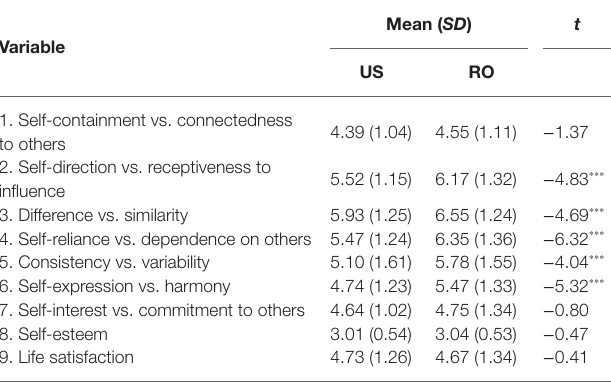
TABLE 7 | Means, SD, and t -tests for differences between the United States and Romanian samples for the variables in the Study 2.